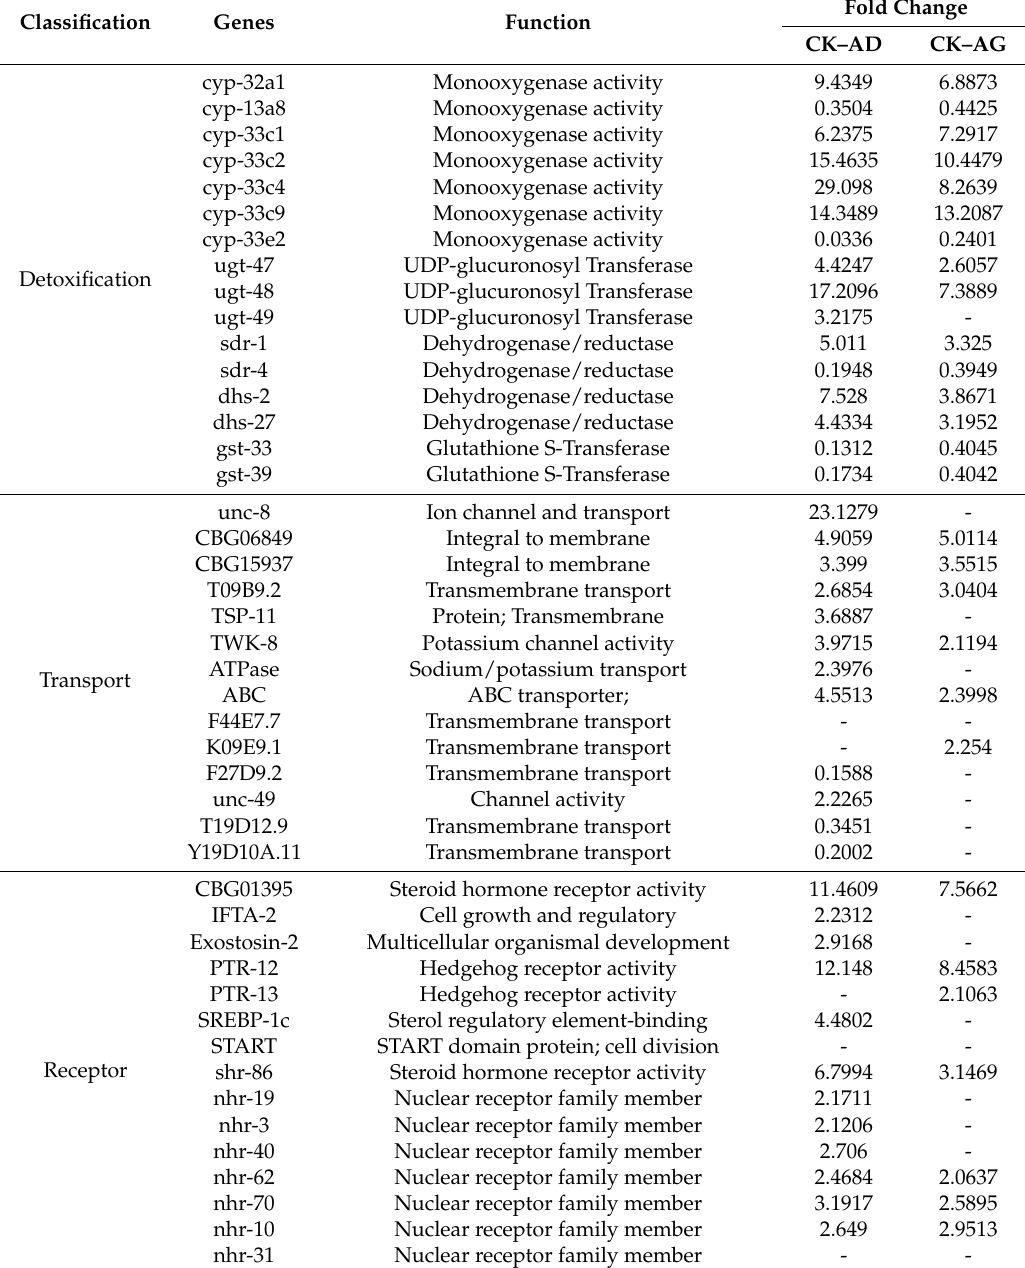
Table 3. Summary of DEGs encoding detoxification, transport, and receptor